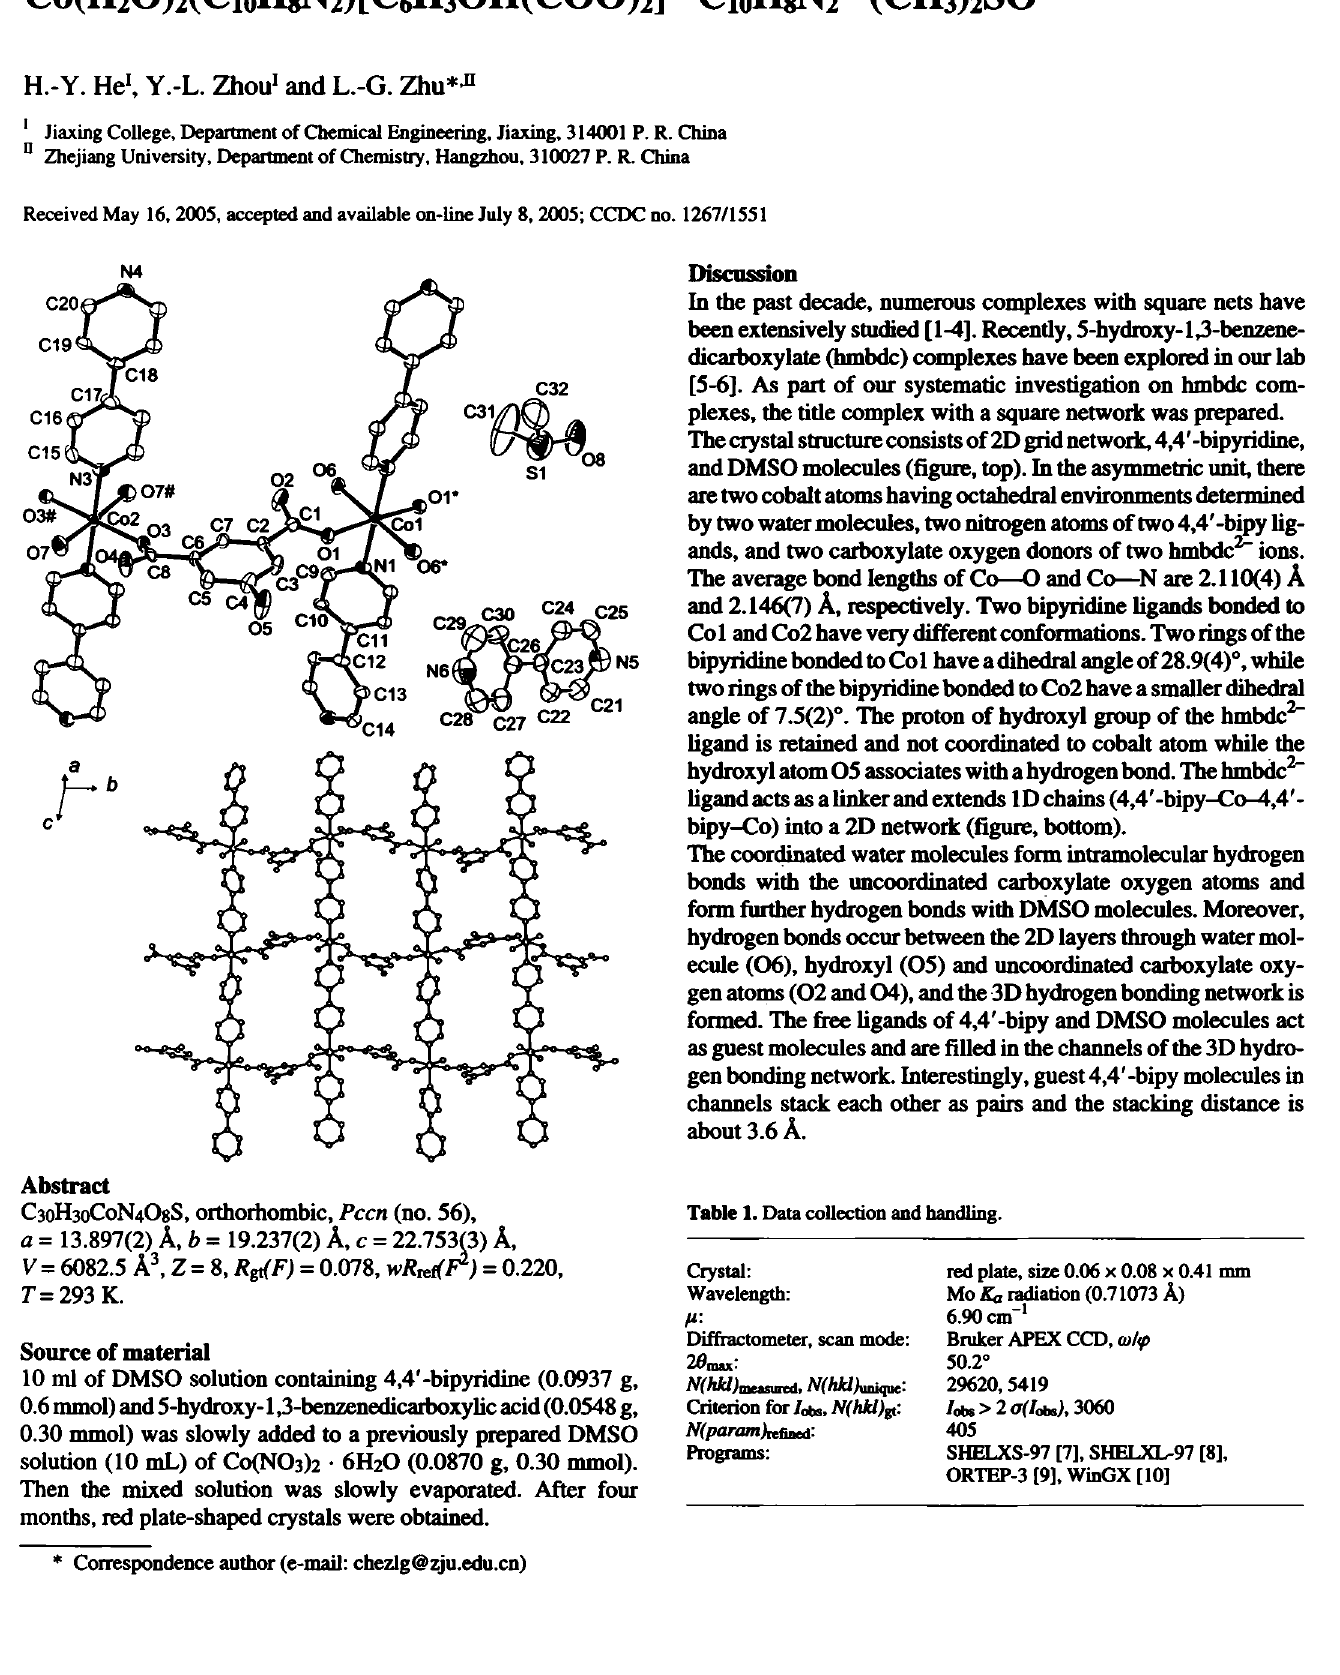
Table 1. Data collection and handling.